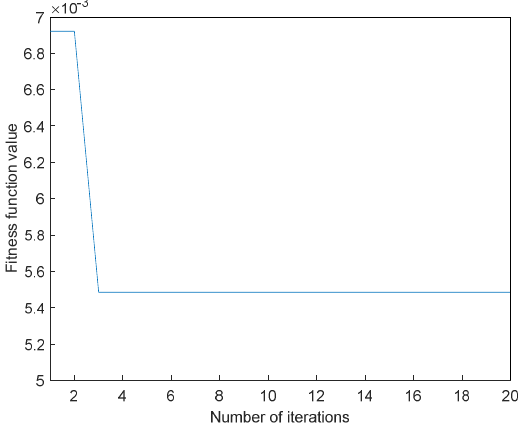
Figure 4. The fitness function varies with the number of iterations.